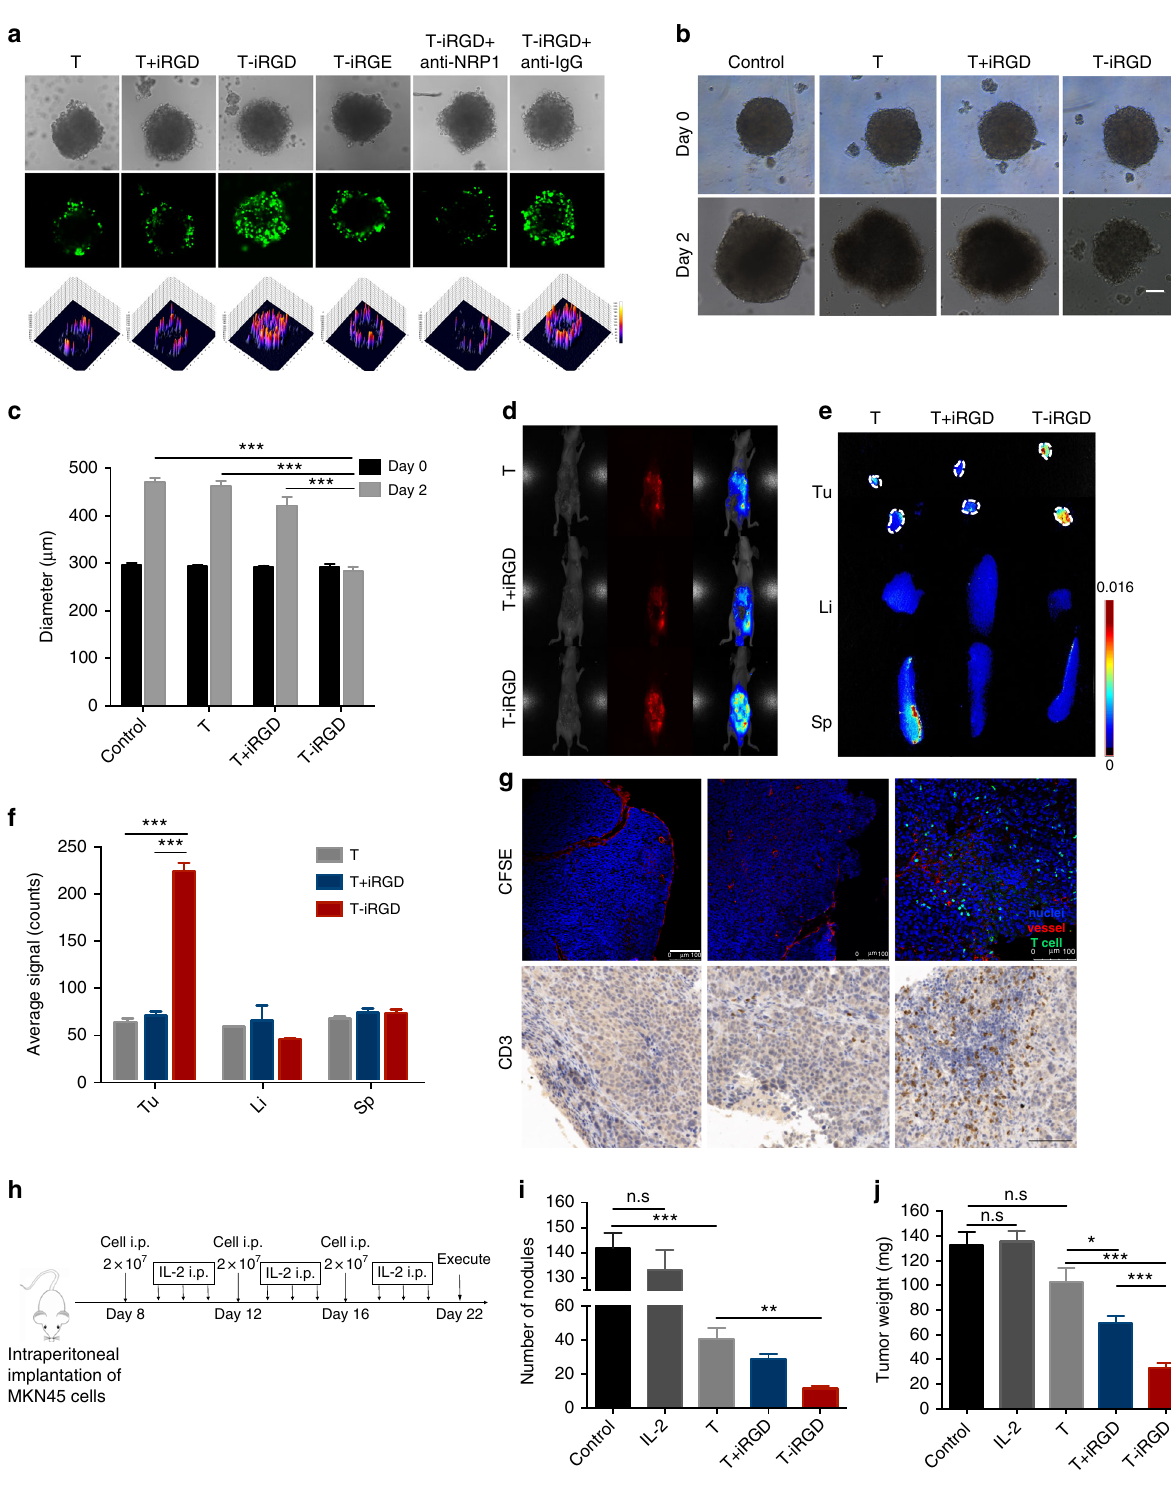
the C-terminal of the peptide. The free sulfhydryl group provided the potential to connect iRGD to the maleimide group of 2-distearoyl-sn-glycero-3-phospho-ethanolamine-N-maleimide (DSPE-PEG-Mal) through Michael addition reaction (Fig. 1a).